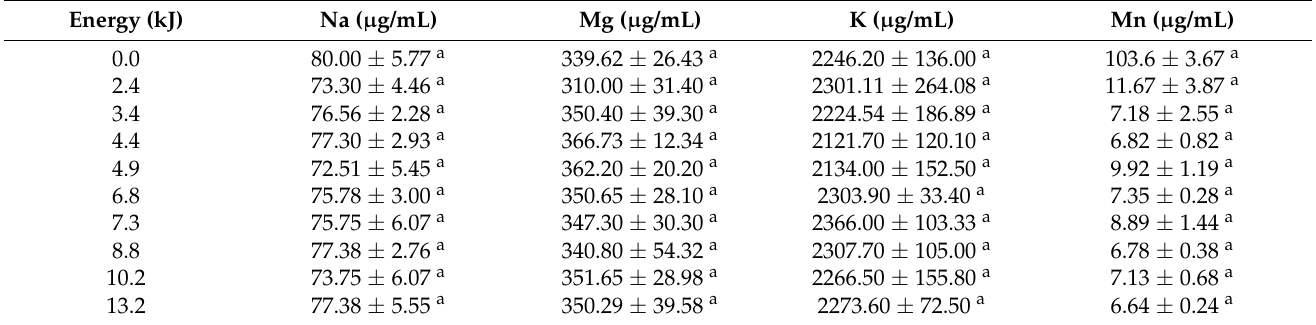
Table 3. Changes in the metal ion concentration of the red wine samples treated by pulsed electric fields.